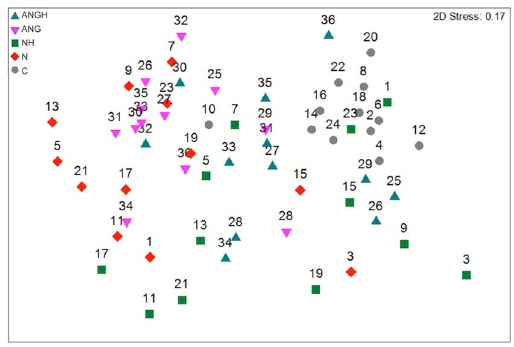
Figure 3. Multidimensional scaling (MDS) plot of Bray-Curtis dissimilarities using multi-dimensional scaling. Numbers corre- spond to individuals sampled, as reported in Figure 1.